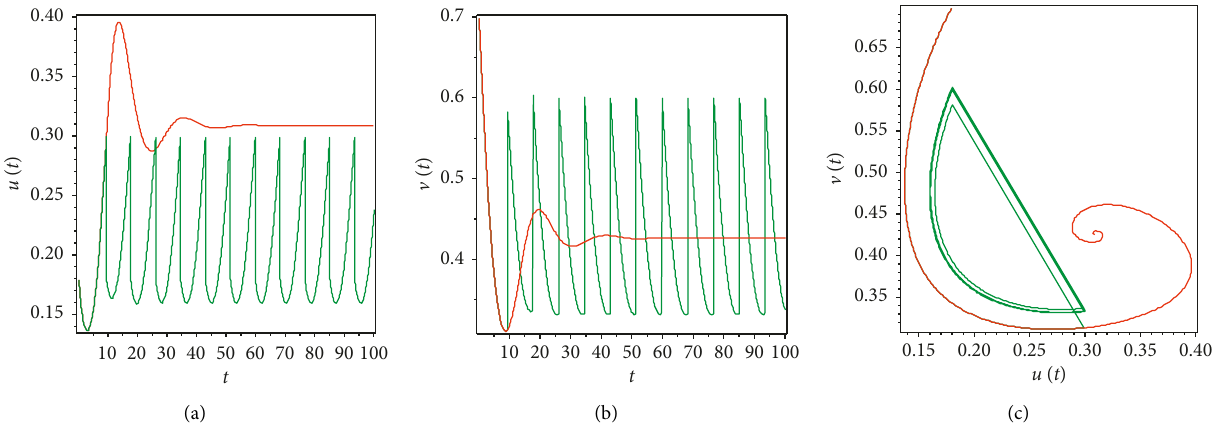
Figure 3: State pulse feedback control strategy of system (5): s � 2, A � 0 . 5, δ � 1, d � 0 . 25, k